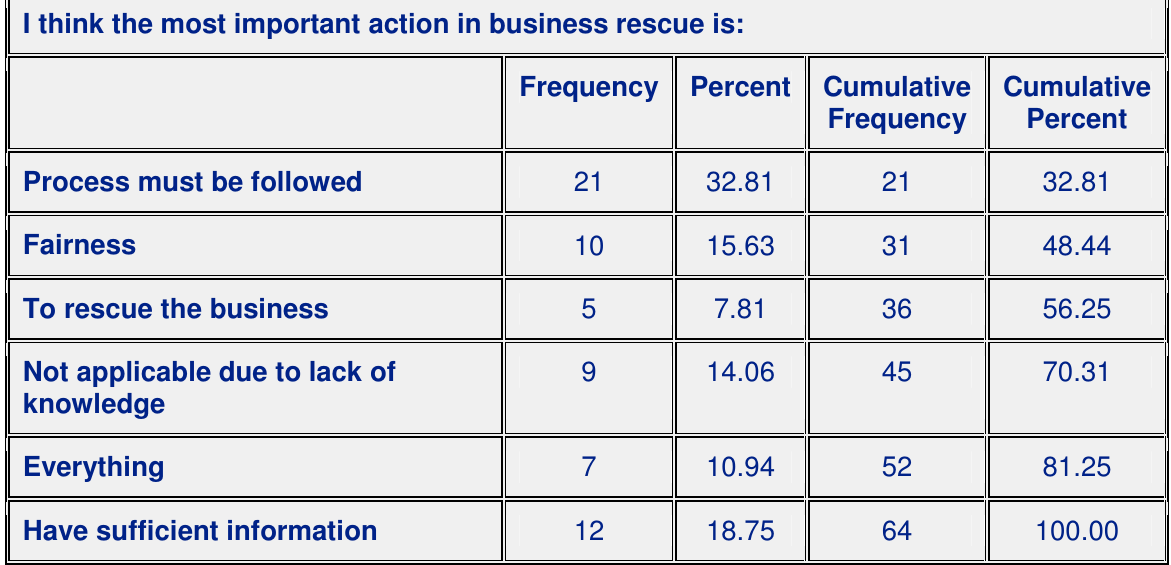
Table 9: Most important action to be taken in a business